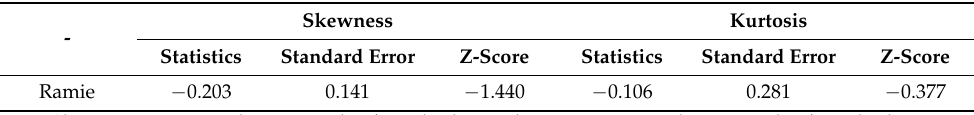
Table 6. Normal distribution test results of annual ramie.